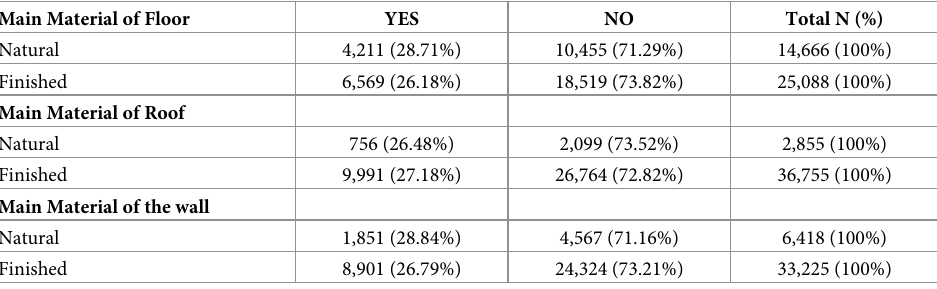
Table 4. Housing quality and percentage of children’s illness with cough in the last two weeks in Punjab, Pakistan. Main Material of